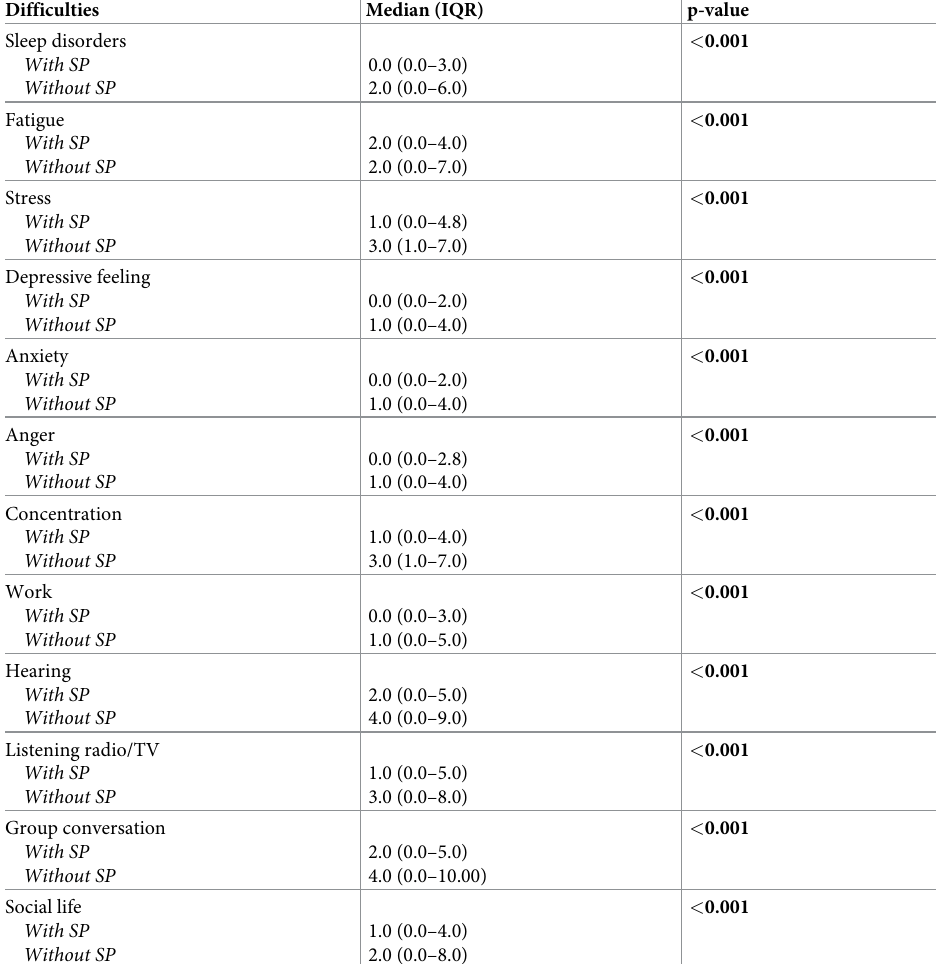
Table 5. Tinnitus-related difficulties with and without sound processor (SP)